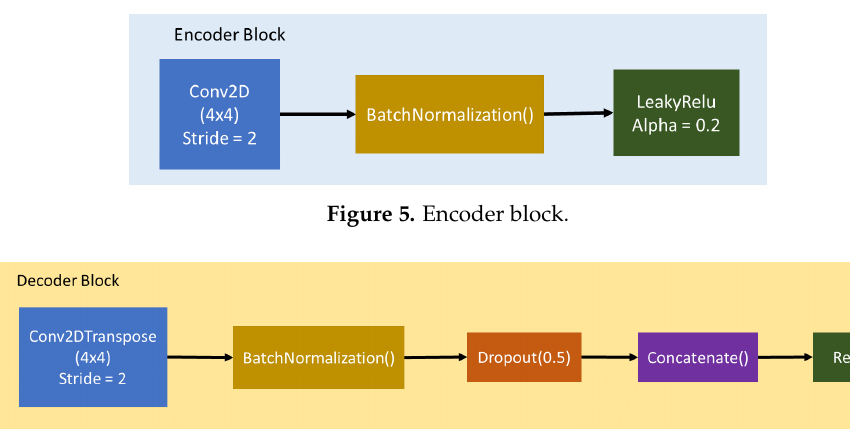
Figure 6. Decoder